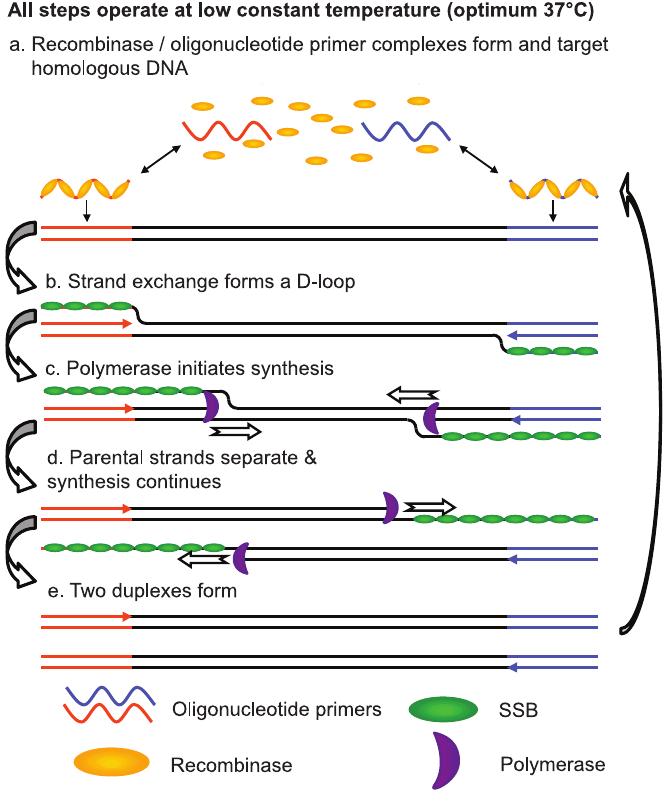
Figure 1. DNA amplification by Recombinase Polymerase Amplification. The three core proteins, recombinase, single-strand DNA binding protein (SSB) and strand-displacing polymerase enable PCR-like DNA amplification without the need for thermal cycling or an initial chemical or thermal melting step. This diagram was created by TwistDx Ltd (http://www.twistdx.co.uk/our_technology/) and is licensed under a Creative Commons Attribution 3.0 United States License.